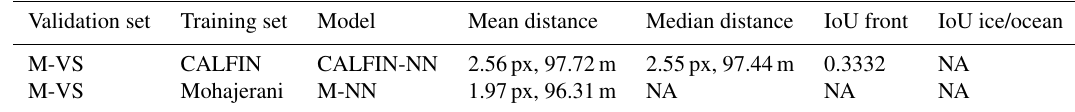
Table 3. M-VS validation output results. Accuracy and error metrics for the CALFIN-NN and the M-NN models on the M-VS. Again, some metrics are not provided by Mohajerani et al. (2019), so they are omitted from this table. NA – not available Validation set Training set Model Mean distance M-VS M-VS